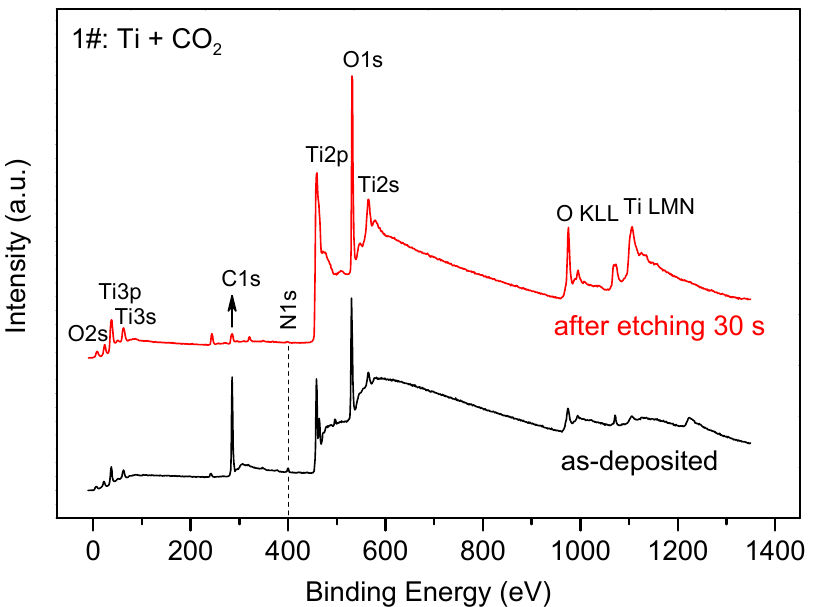
Figure 3. XPS survey spectra of the C-doped Ti–O film (sample 1#): as-prepared and after etching for 30 s.